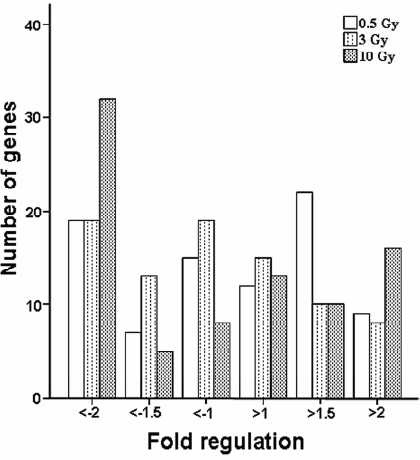
Figure 3. Distribution of fold regulations of all genes tested after a low-, medium-, or high-dose